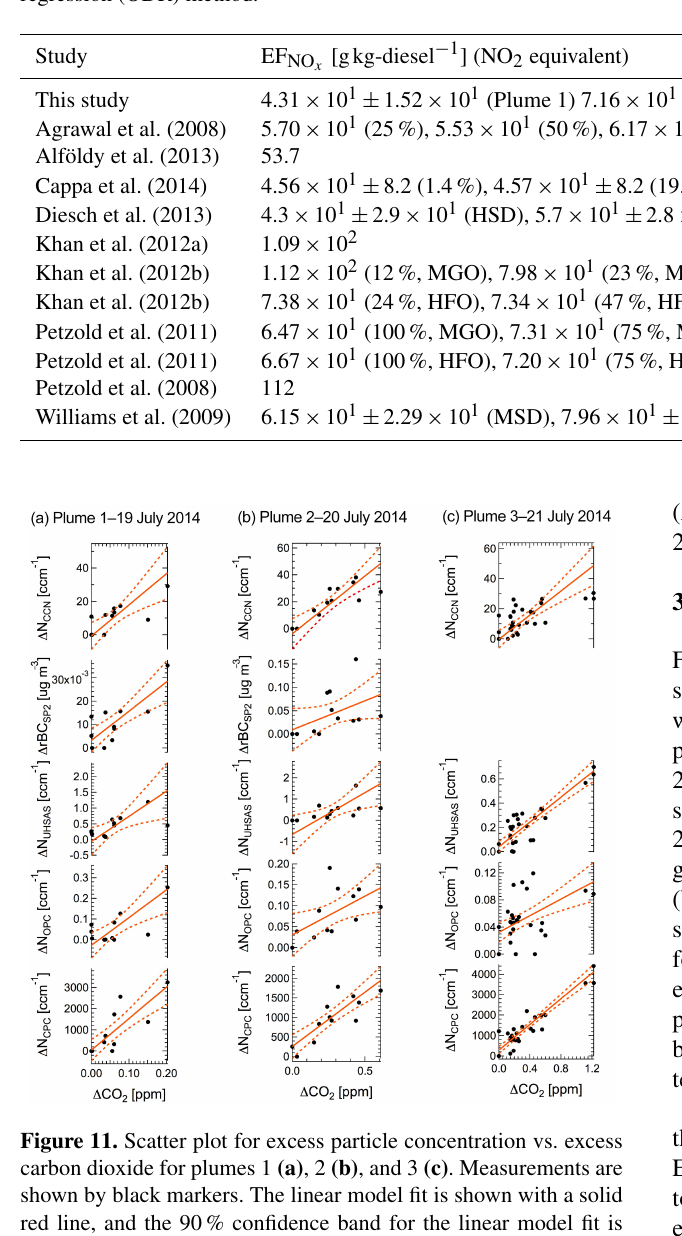
Table 3. Emission factors for NO x ; numbers in brackets indicate engine load (%), fuel type (HFO: heavy fuel oil with high sulfur content, and MGO: marine gas oil with low sulfur content), or vessel class based on gross metric tonnage (HSD: high speed diesel < 5000t, MSD: medium speed diesel 5000–30000t, or SSD: slow speed diesel > 50000t); the uncertainty is computed using the orthogonal distance regression (ODR) method.